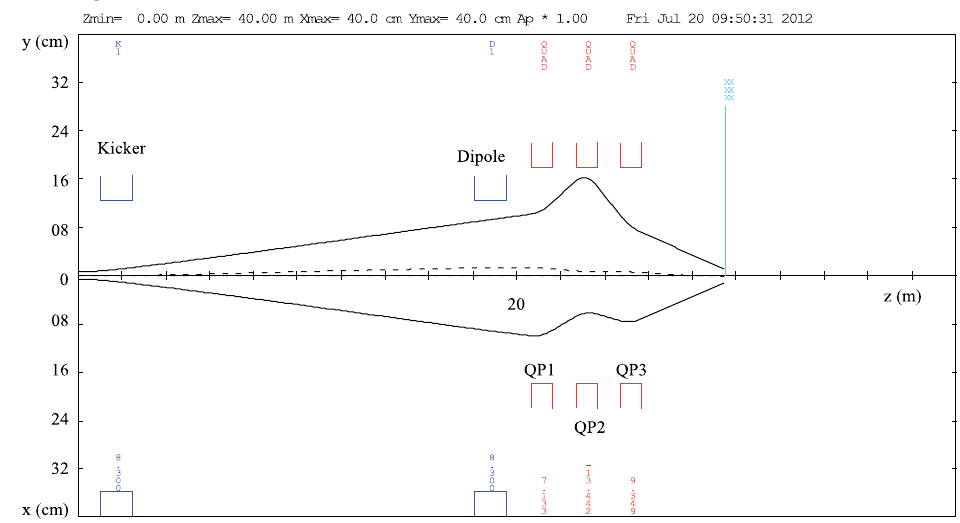
FIG. 6. Transverse beam envelopes. The dashed line represents the spatial dispersion. The initial beam parameters